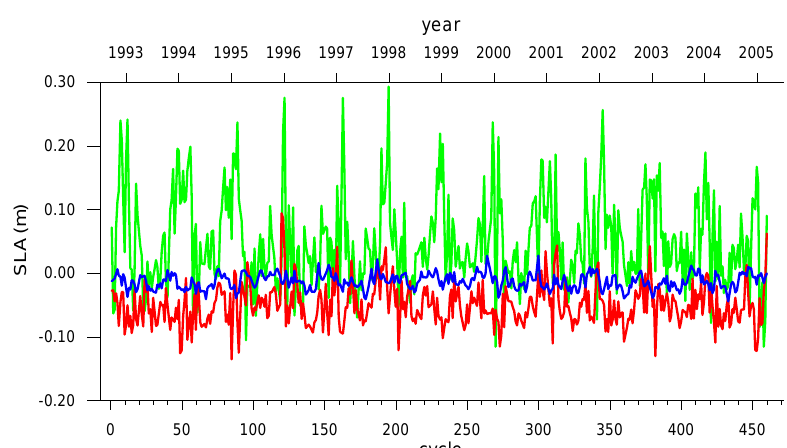
Figure 7a. SLA differences DataSet1-DataSet4 (non-IB-corrected versus IB Constant Reference Pressure) blue - Tropical; red : Sub-Tropical; green: Sub-Arctic.